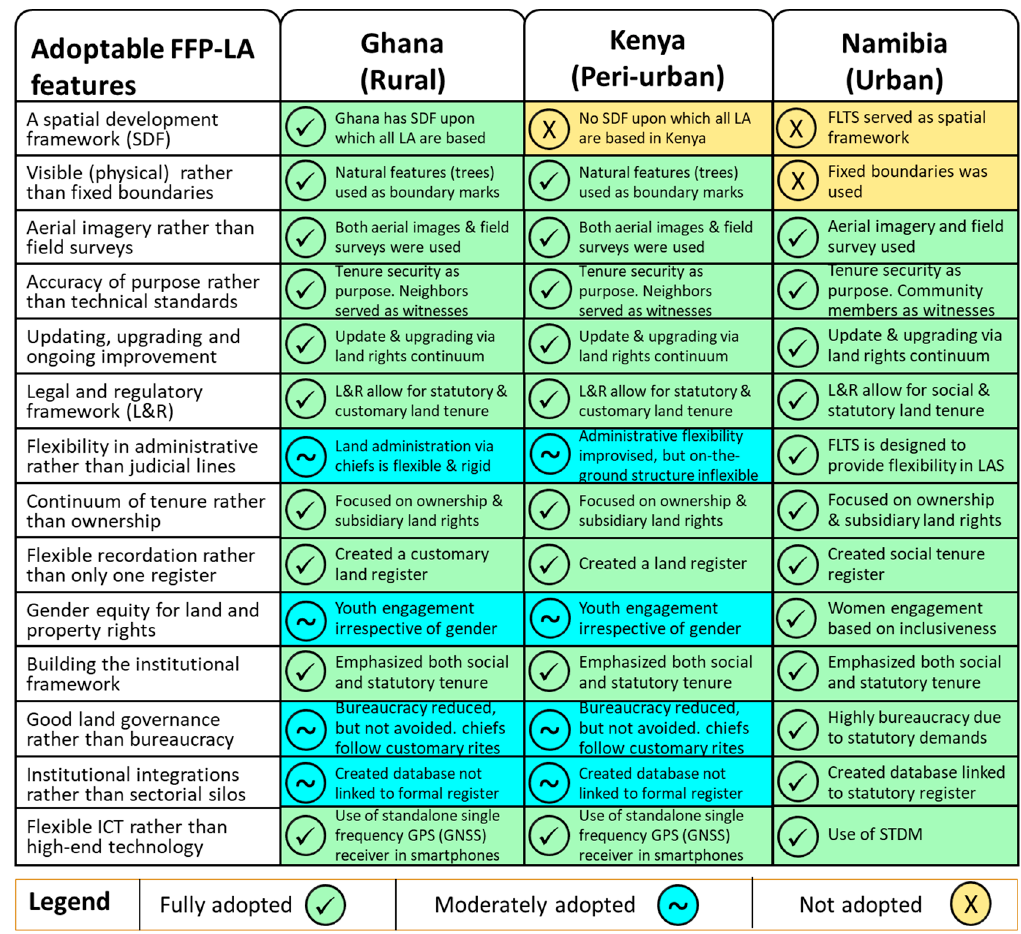
Figure 6. Matrix of case studies’ adoption of the FFP-LA features (Source: Authors’). Figure 6 is a matrix showing the adoption of FFP-LA features. In the matrix, the green, blue, and yellow shades represent the qualitative extent of FFP-LA adoption in the case studies. Green represents fully adopted , blue entails moderately adopted , and yellow indicates not adopted . Focusing on the case study matrix, we discuss the what and how in relation to the adoption of the FFP-LA features identified by Enemark et al. [10]. These features were adopted at the local-level in the case studies in Ghana, Kenya, and Namibia, as described